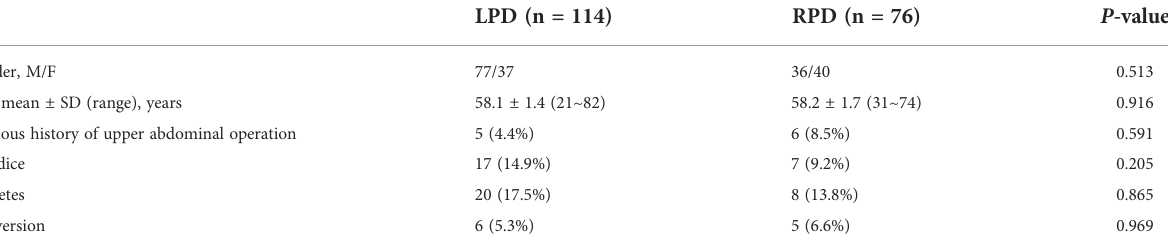
TABLE 1 General data and conversion of preoperation.